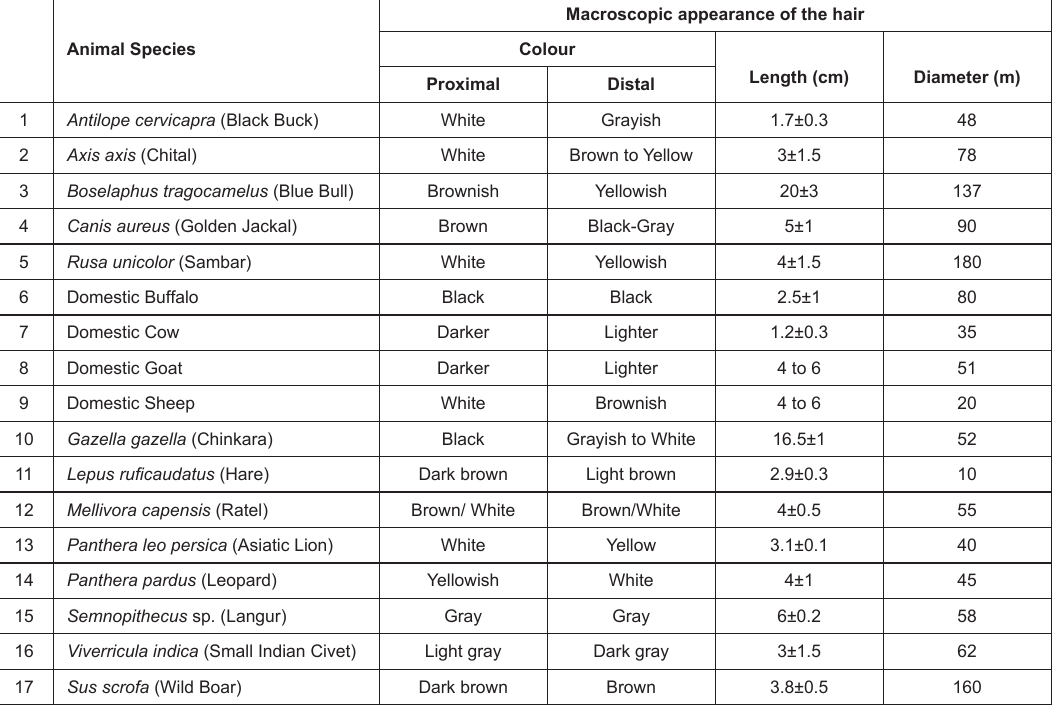
Table 1. Macroscopic characteristics of mammalian hair for rapid identification Animal Species